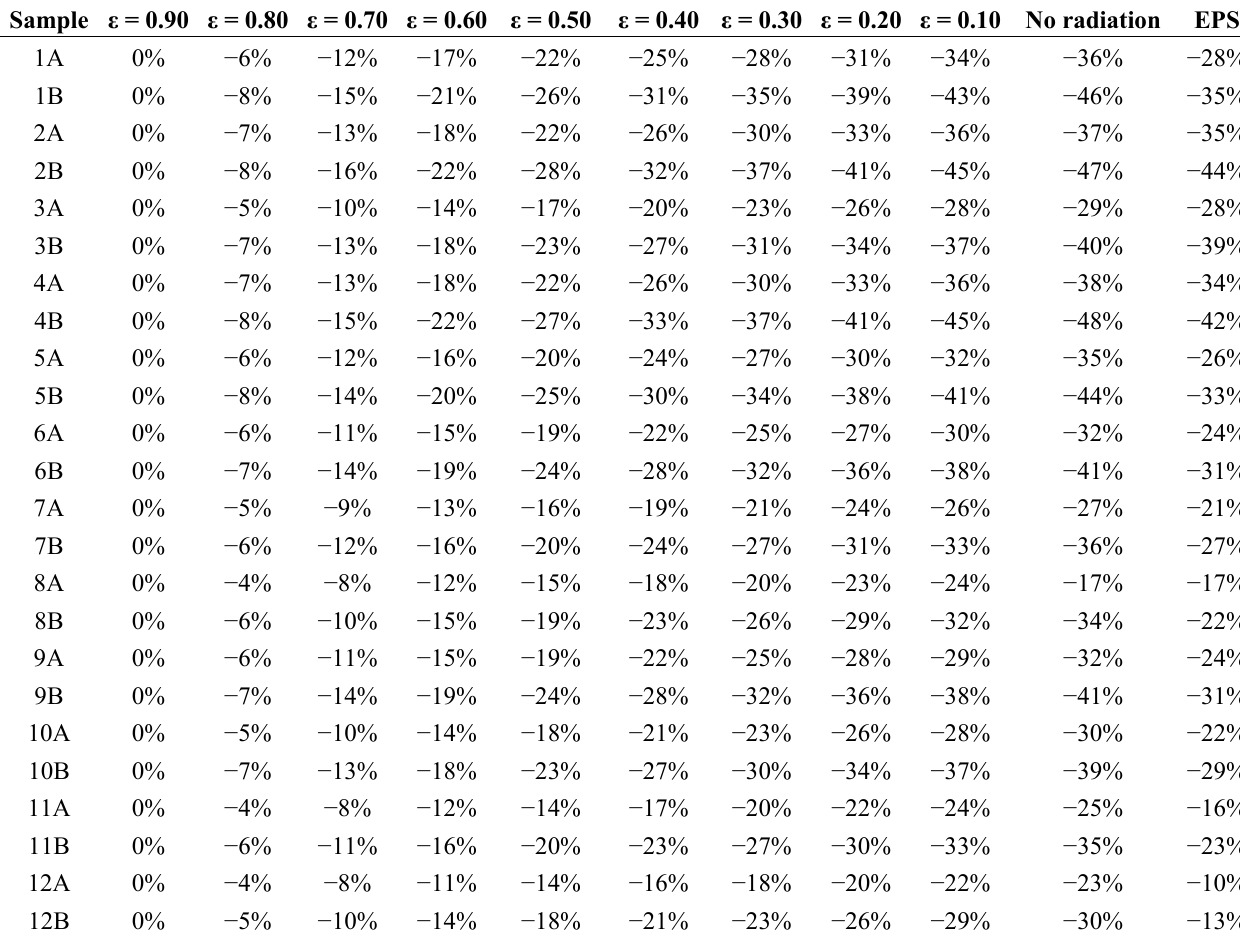
Table 7. Equivalent thermal conductivity of the evaluated block: percentage of